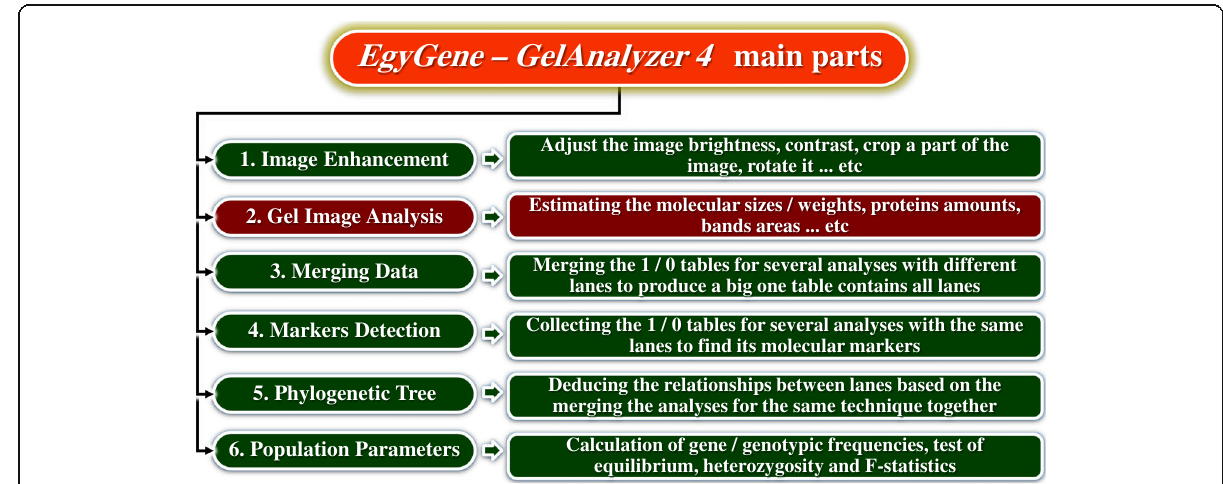
Fig. 1 Illustration of the six main parts of the EgyGene GelAnalyzer4